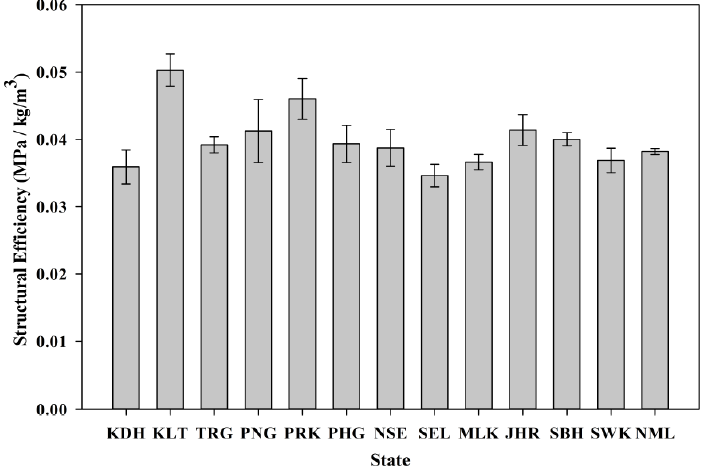
Figure 14. Structural efficiency for all states.